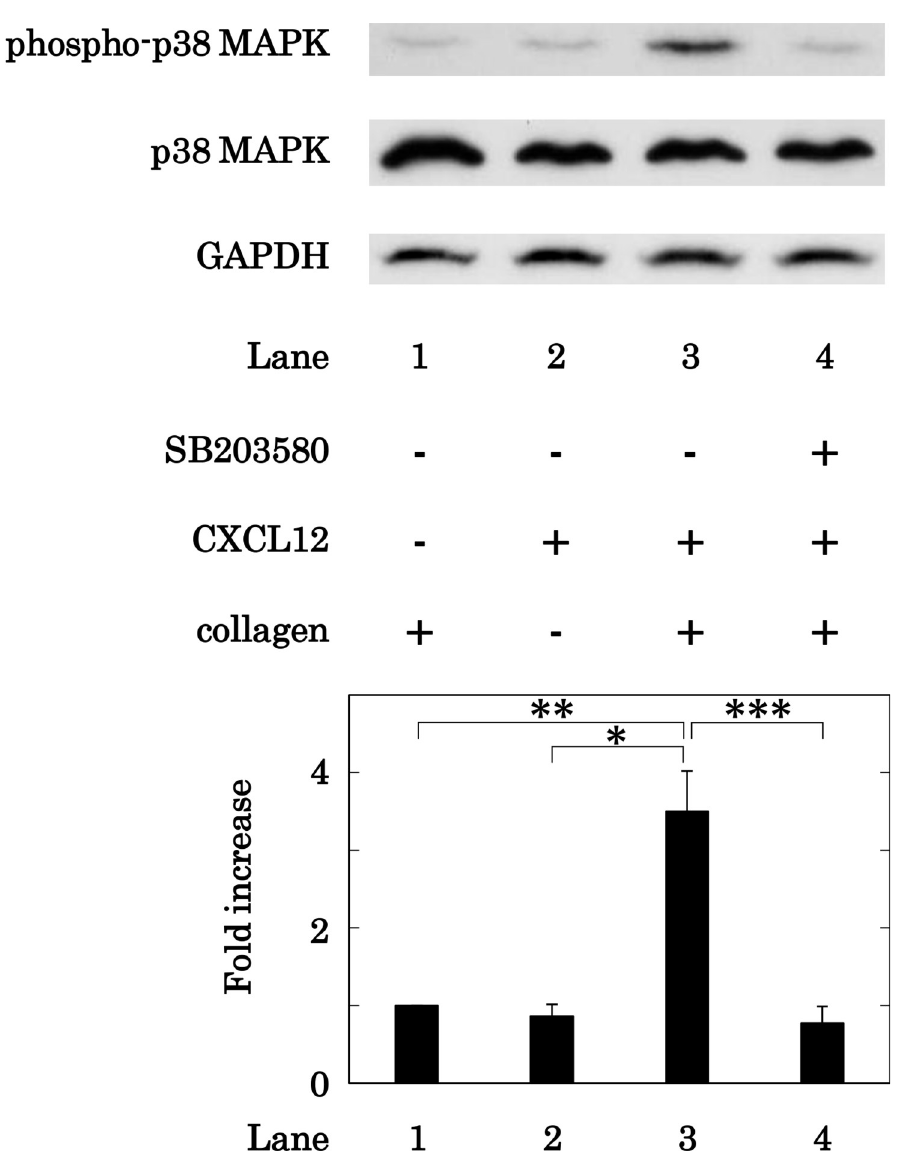
Fig 10. Effect of SB203580 on the phosphorylation of p38 MAPK in human platelets induced by simultaneous stimulation with collagen and CXCL12 in low doses. PRP was pretreated with 30 μ M of SB203580 or vehicle for 3 min and then simultaneously stimulated by 0.1–0.2 μ g/ml of collagen and 10 ng/ml of CXCL12 for 5 min. The reaction was terminated by the addition of ice-cold EDTA (10 mM) solution. The lysed platelets were subjected to Western blot analysis using antibodies against phospho-specific p38 MAPK, total p38 MAPK, or GAPDH. The histogram shows a quantitative representation of the co-stimulation with collagen and CXCL12-induced levels obtained from a densitometric analysis. The phosphorylation is expressed as the fold increase compared to the levels of collagen alone, presented as lane 1. Each value represents the mean ± SEM of 5 times independent experiments. � p < 0.05, compared to the value of CXCL12 alone. �� p < 0.05, compared to the value of collagen alone. ��� p < 0.05, compared to the value of simultaneous stimulation of collagen and